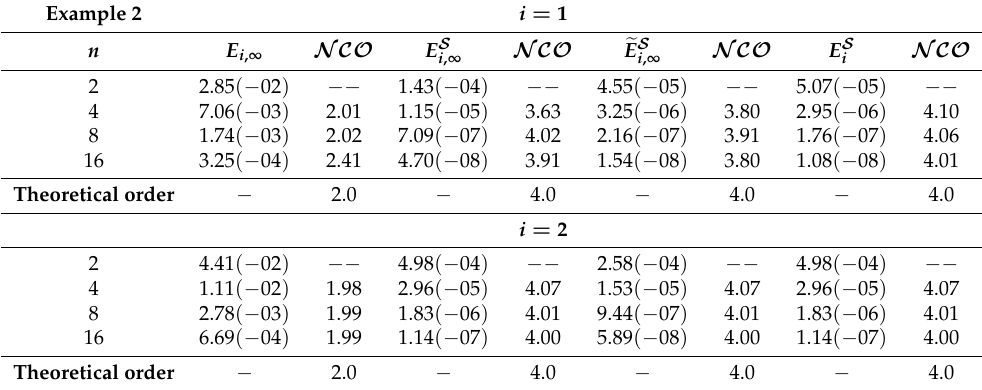
Table 2. Numerical methods based on piecewise constant functions ( r = 1 ) .